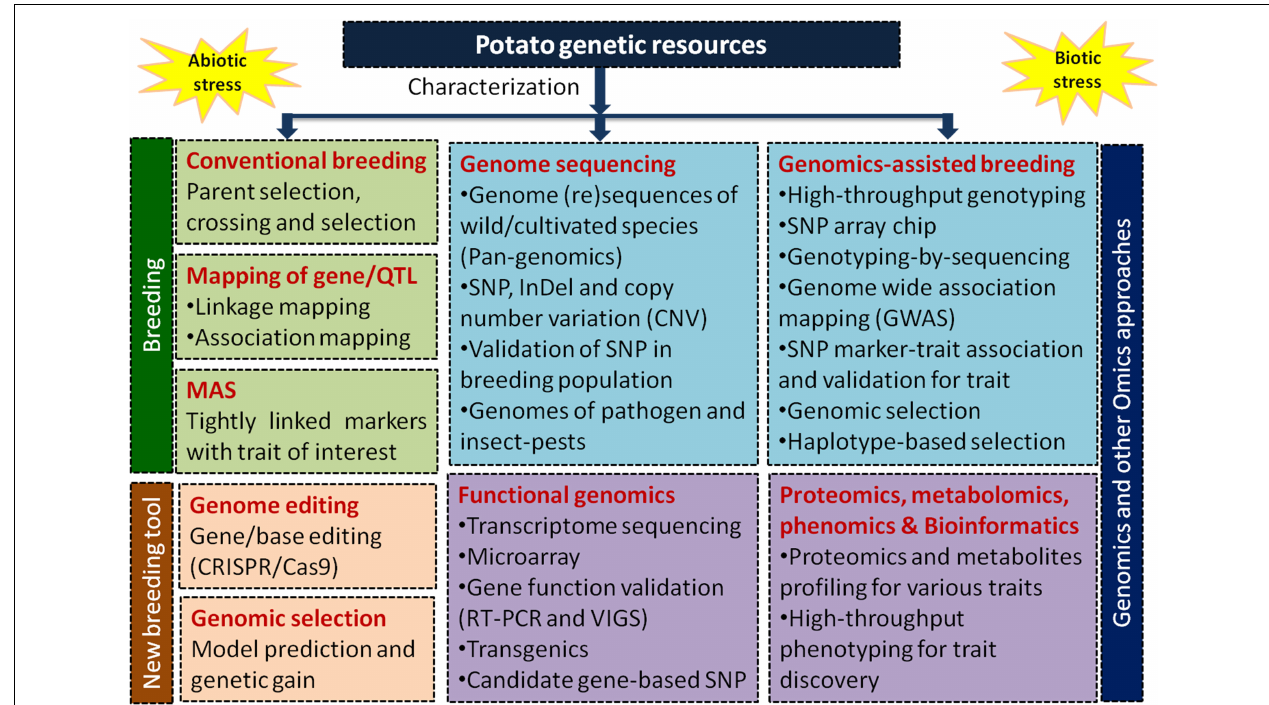
FIGURE 1 | A schematic presentation of different approaches used for genetic enhancement and improvement of potato under various biotic and abiotic stresses applying breeding and modern genomics approaches like genome sequencing, functional genomics, genomics-assisted breeding through high-throughput genotyping by SNP markers, omics (transcriptomics, proteomics, metabolomics, and ionomics), high-throughput phenotyping, genome editing, and genomic